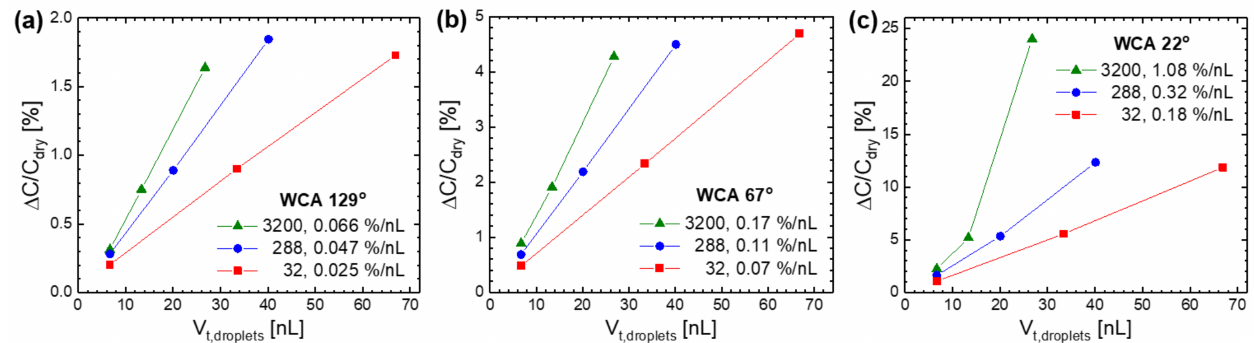
Figure 8. FEM simulation results on the increase in sensor capacitance according to the total volume of water droplets with different numbers (32, 288, 3200) on the substrate top surface of the IDE sensors with different WCA: ( a ) 129 ◦ , ( b ) 67 ◦ , and ( c ) 22 ◦